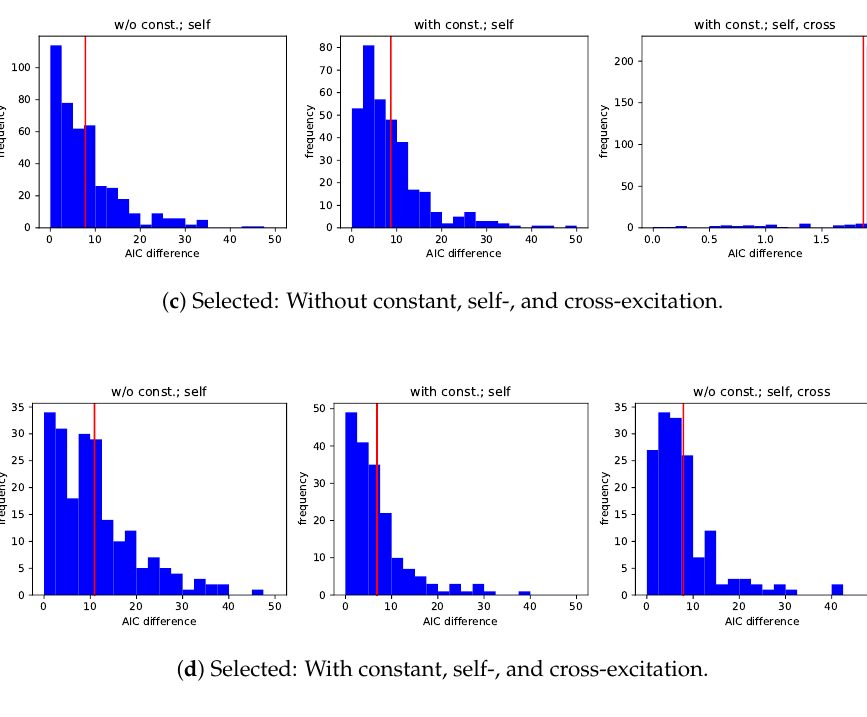
Figure 3. Histograms of AIC differences conditional on whether the best model is the one with self-excitation ( left ) or the one with self and cross-excitation ( right ). Cases where the AIC difference of the model with self- and cross-excitation is greater than the maximum are removed from the